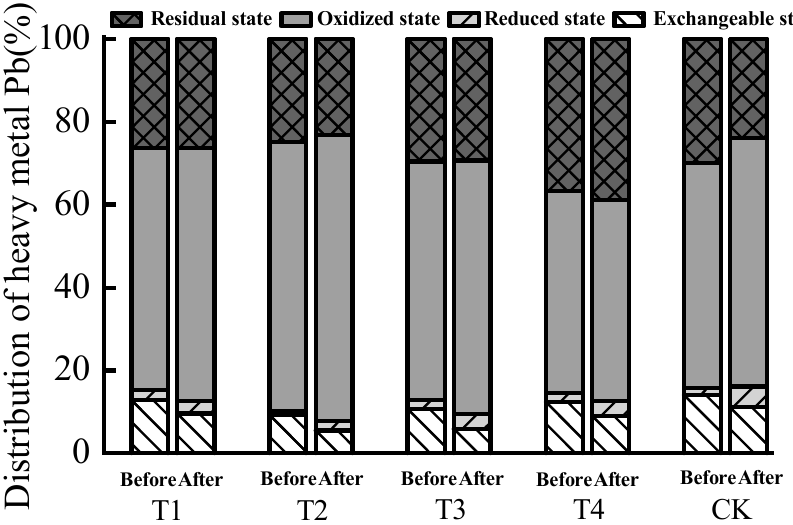
Figure 4. Distribution rate of various forms of Pb before and after biogas residue composting.